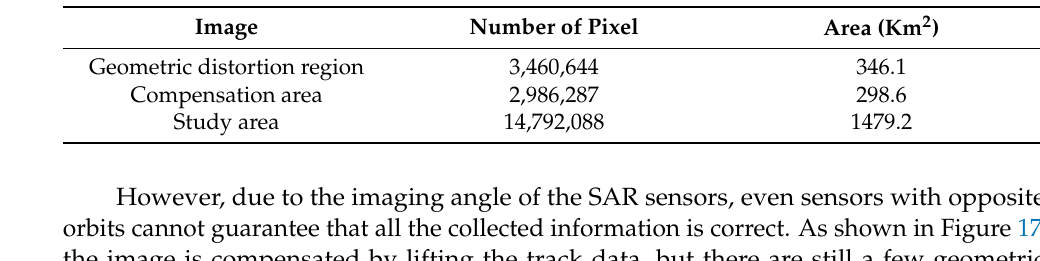
Table 4. Compensation situation. Figure 17. Cont